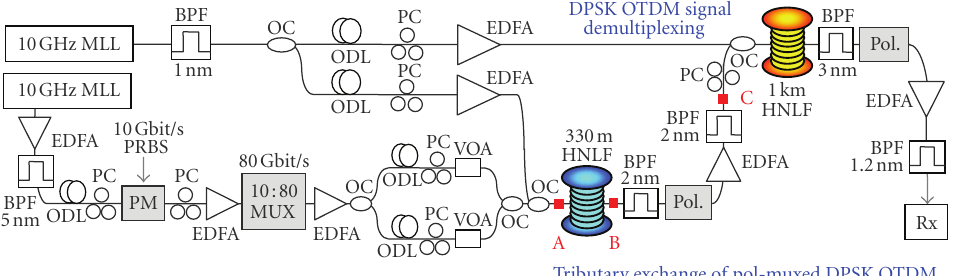
Figure 30: Experimental setup for the demultiplexing of a DPSK OTDM signal and the orthogonal tributary channel exchange of a pol- muxed DPSK OTDM signal. HNLF: highly nonlinear fiber; MLL: mode-locked laser; EDFA: erbium-doped fiber amplifier; ODL: